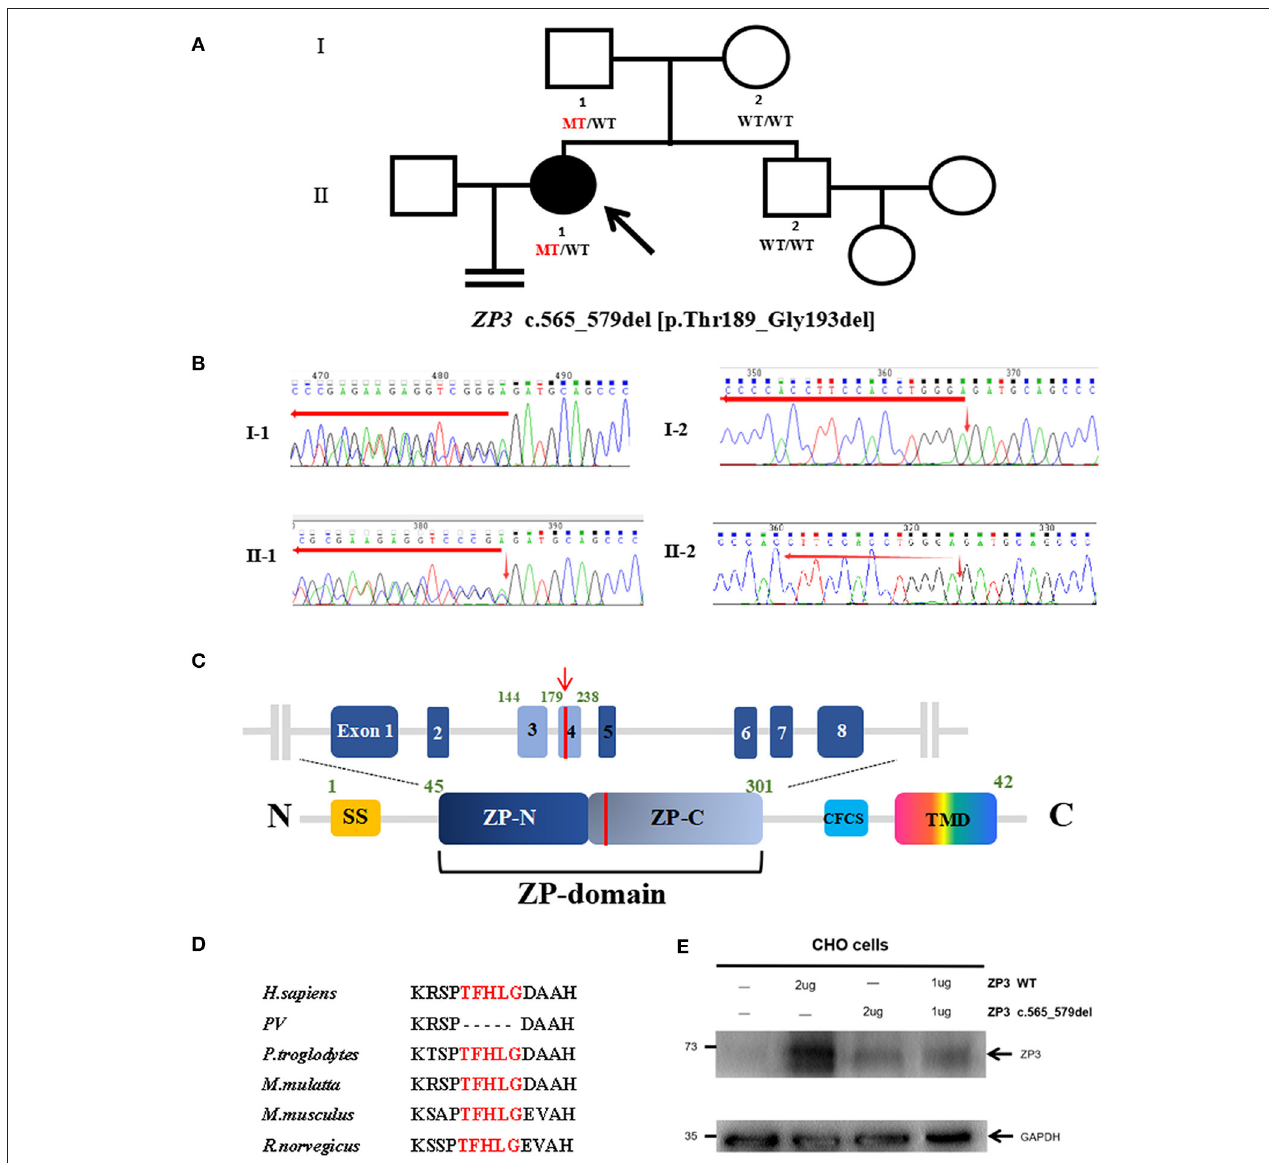
FIGURE 1 | Genotypic features of the EFS patient. (A) Pedigrees of the family with EFS and female infertility. The filled circle indicates the EFS patient. The arrow indicates the proband. The ZP3 genotype for each subject detected is shown, with WT indicating a normal allele and MT indicating the mutant allele. (B) Sanger genotype of ZP3 for each individual. (C) Location of the mutation (red line) is indicated in the genomic structure (top) and domain organization (bottom) of ZP3. SS, signals sequence; CFCS, consensus furin cleavage site; TMD, transmembrane domain. (D) Thr189_Gly193 is highlighted in red and conserved in the selected species. (E) Expression of wild-type (WT) and mutant ZP3 proteins in Chinese hamster ovary (CHO) cells examined by immunoblot analysis using anti-ZP3